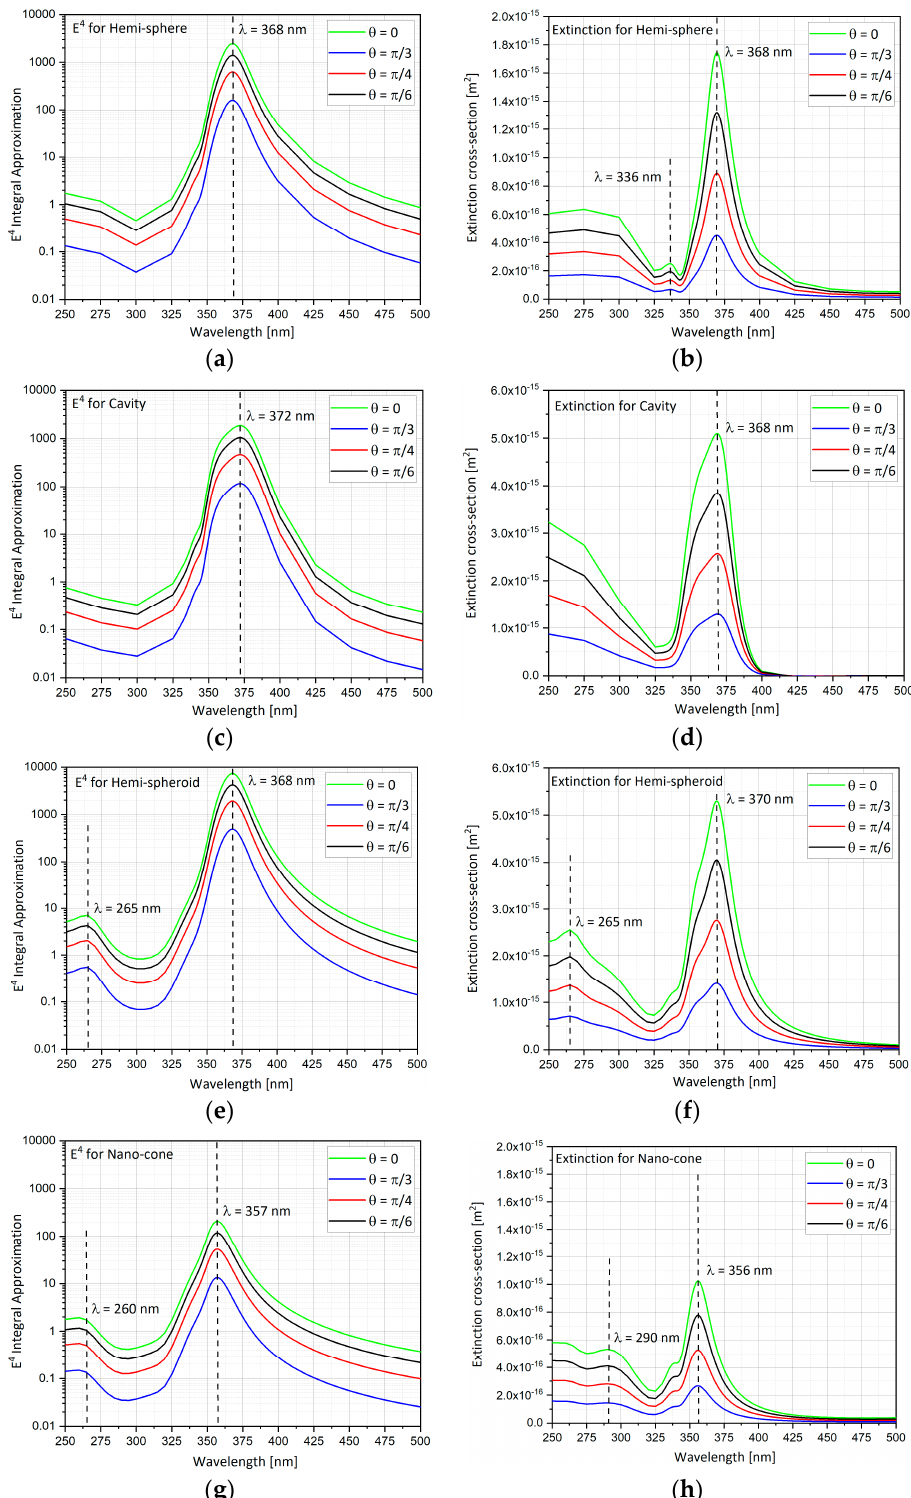
Figure 8. E 4 approximation and extinction cross-section for changing polar angle θ in wavelengths range of λ = 250–500 nm. ( a ) E 4 approximation for hemi-sphere; ( b ) extinction for hemi-sphere; ( c ) E 4 approximation for cavity; ( d ) extinction for cavity; ( e ) E 4 approximation for hemi-spheroid; ( f ) extinction for hemi-spheroid; ( g ) E 4 approximation for nano-cone; ( h ) extinction for nano-cone.